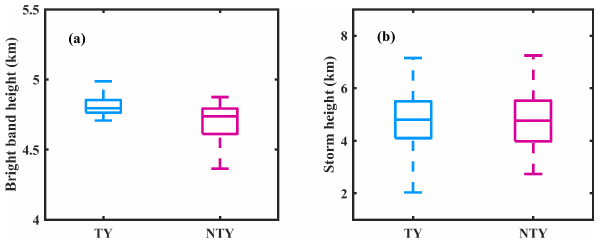
Figure 14. (a) Bright band (BB) and (b) storm height box plots for typhoon (TY) and non-typhoon (NTY)